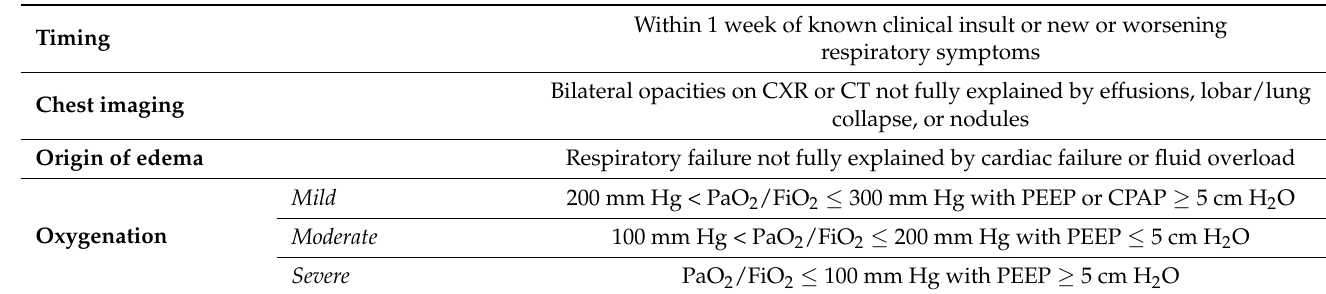
Table 1. Berlin Definition of Acute Respiratory Distress Syndrome. CXR , chest X-ray; CT , computed tomography; PaO 2 /FiO 2 , partial pressure of arterial oxygen to fraction of inspired oxygen ratio; PEEP , positive end-expiratory pressure; CPAP , continuous positive airway